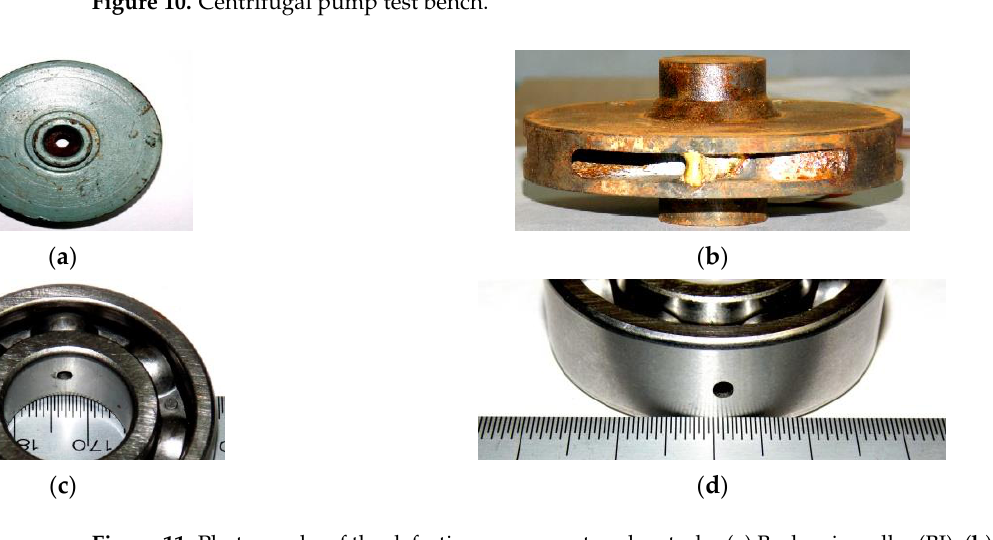
Figure 10. Centrifugal pump test bench.